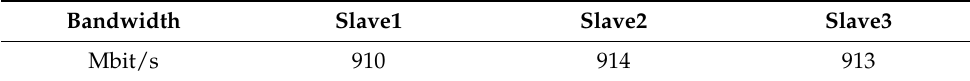
Figure 5. Cluster network configuration. Table 4. iperf benchmark between slave servers and master server.